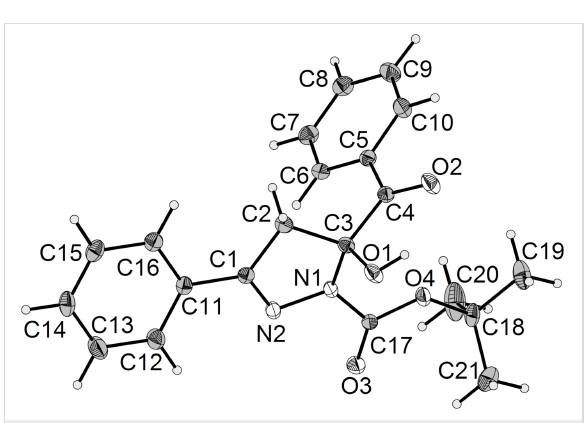
Figure 4: Ellipsoid plot of 1-Boc-5-benzoyl-5-hydroxypyrazoline 5a